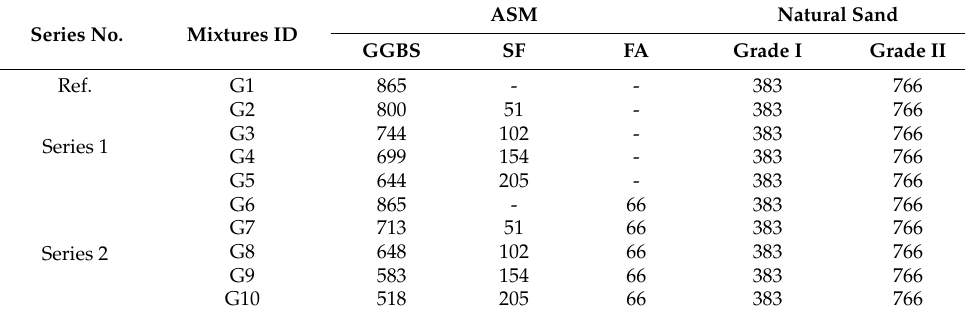
Figure 3. Schematic temperature exposure regimen.